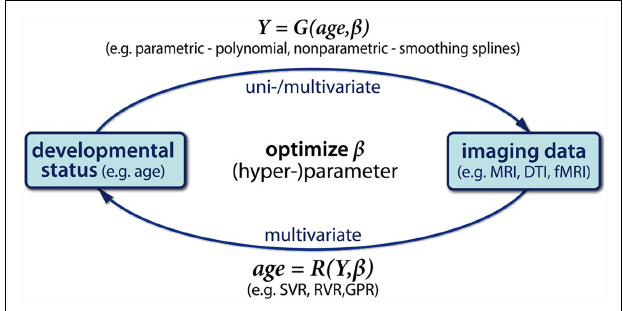
FIGURE 1 | Schematic illustration of generative and recognition models of age. A generative model G predicts the brain structural differences Y as a univariate or multivariate parametric function of age (top). Conversely, recognition models R predict individual’s age or age-group based on brain differences Y (bottom). According to the multidirectionality, age trajectories are not assumed to be strictly increasing or decreasing functions of age, e.g., inverted-U shaped. Consequently, in case of continuous age, these univariate recognition models are not reasonable (see also Friston and Ashburner,